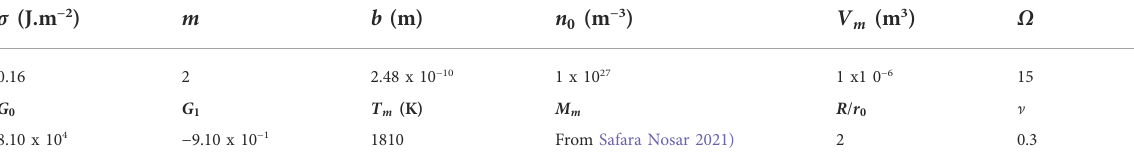
TABLE 3 Intrinsic properties and thermodynamics-related parameters.